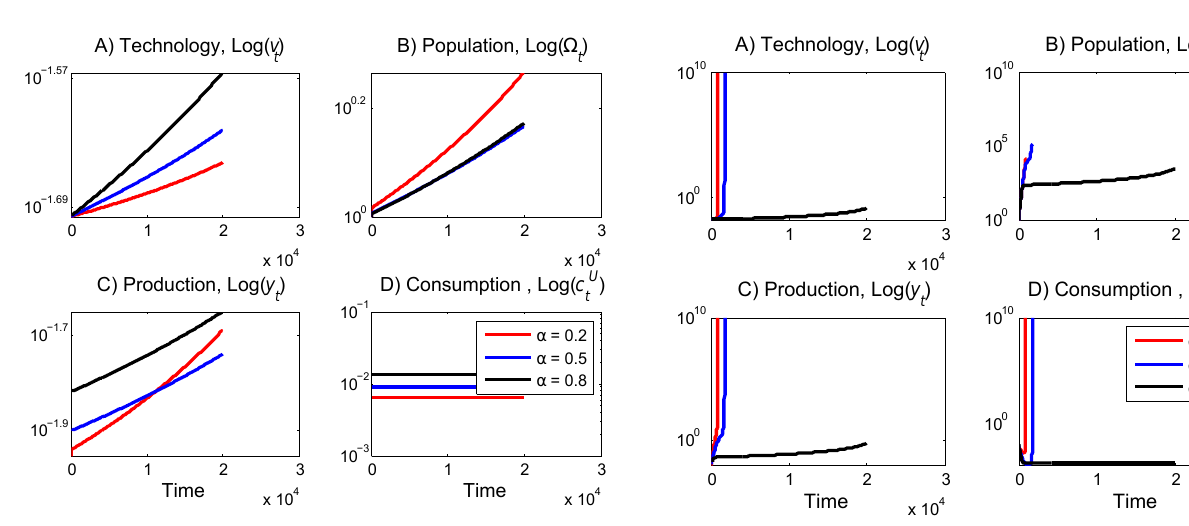
Figure 12. Case of a resilient society with marginally productive skilled labor. Assumptions: η = 0.01 to represent a highly vulnera- ble society, low effectiveness of investment on technological change − α − β = 0 . 35 ( γ = 1 E − 3), 1 and constant availability of water re- β 0 . 3 sources (i.e., k =